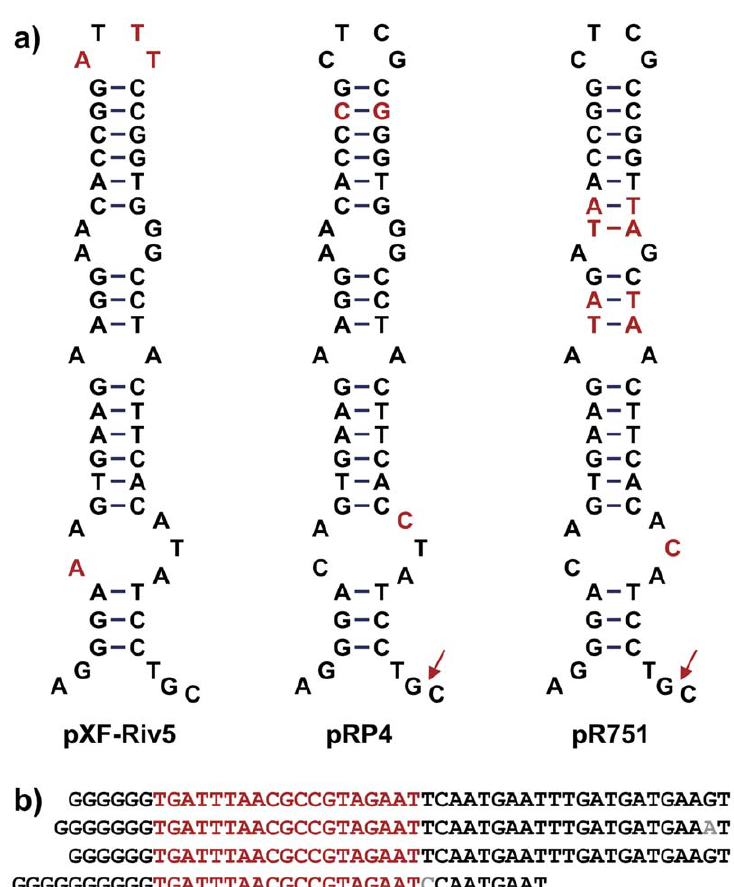
Figure 3. Structure of oriT and oriV . A) oriT inverted repeats from pXF-RIV5, pRP4, and pR751 are shown as stem-loop structures to emphasize potential base parings. Unique bases are shown in red; bases conserved in at least two structures are shown in black. Red arrows indicate experimentally determined cleavage sites in pRP4 and pR751 [21]. B) Tandem repeats in pXF-RIV5 oriV are aligned and the 19-bp core is shown in red. Residues that vary from the consensus are shown in gray. Nucleotides shown (34333 – 34503) are contiguous.